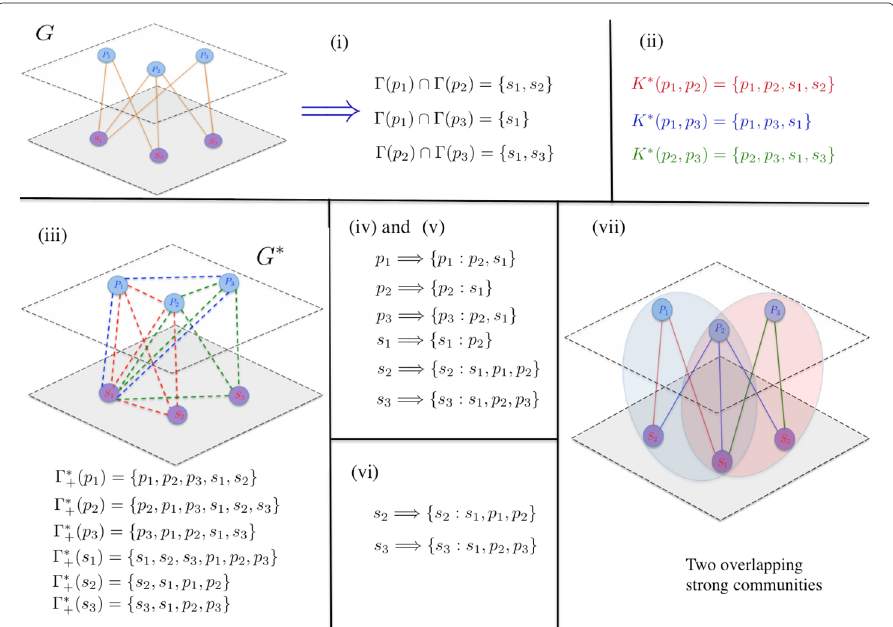
Fig. 2 Schematic illustration on toy example. In ( i ) we find basic bicliques, and then in ( ii ) we treat them as cliques. In ( iii ) we find inclusive neighborhoods for each node in cliques. In ( iv ) and ( v ) comparison between sets of nodes detects structural similarity between sets in order to merge them into larger bicliques. In ( vi ) the final two sets after merging are presented, and finally in ( vii ) the two overlapping strong communities are shown